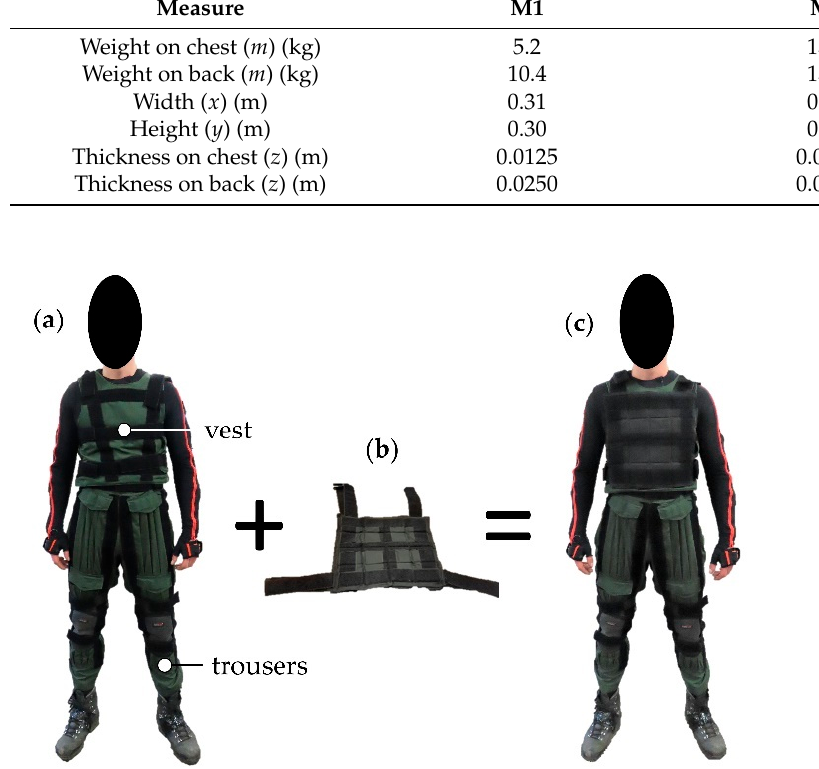
Figure 2. The agility suit worn during the experiment. ( a ) Subject is wearing the vest and pair of trousers. ( b ) High density mass pads of 5.2 kg each can be added to investigate the effect of weight. ( c ) The mass pads are attached to the vest. The load is divided on the front and back of the subject (details are given in Table 1). Table 1. Specifications of the external load segment for the two loaded conditions (M1 and M2).